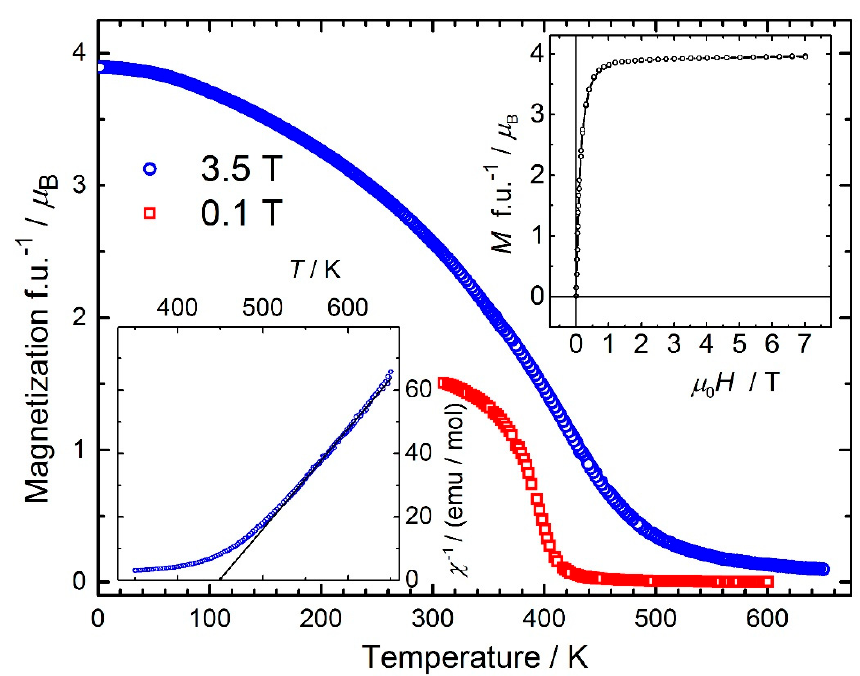
Figure 6. Main panel: Temperature dependence of the magnetization of Fe 2 MnN measured in high (3.5 T) and low (0.1 T) magnetic fields. Upper inset: Field dependence of the magnetization at T = 1.8 K. Lower inset: Inverse high-temperature susceptibility measured at 3.5 T. The black line shows a linear fit of the data above 550 K. Table 3. Magnetic moments, Curie temperatures T C , unit cell parameters and thermal decomposition